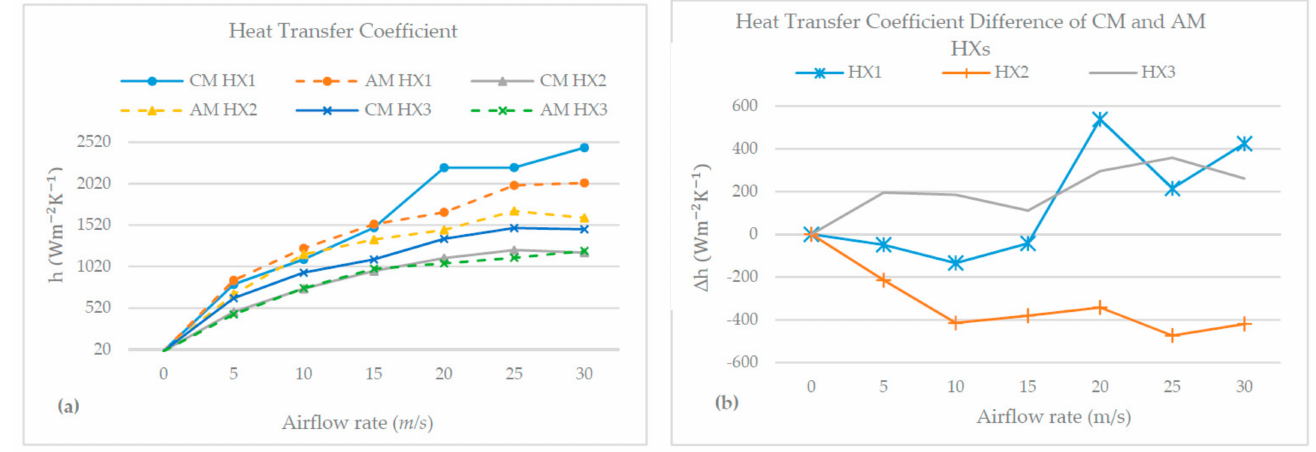
Figure 4. Experimental results when the heater temperature was 50 ◦ C: ( a ) convective heat transfer coefficient and ( b ) convective heat transfer coefficient difference between CM– and AM–HXs.